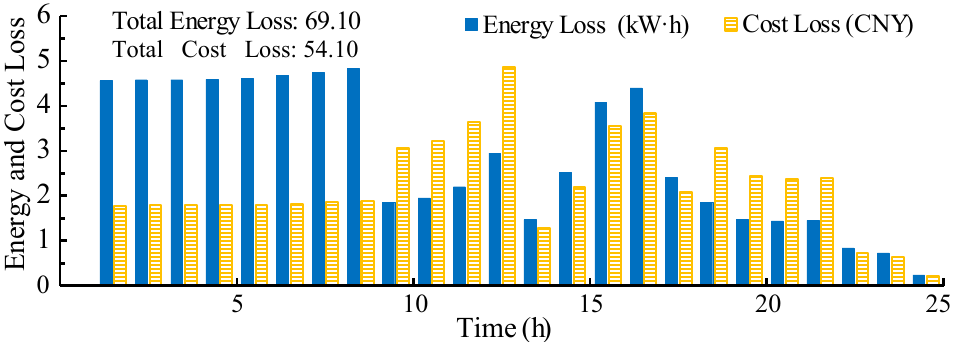
Figure 10. Voltage amplitude of the microgrid in 24 h.